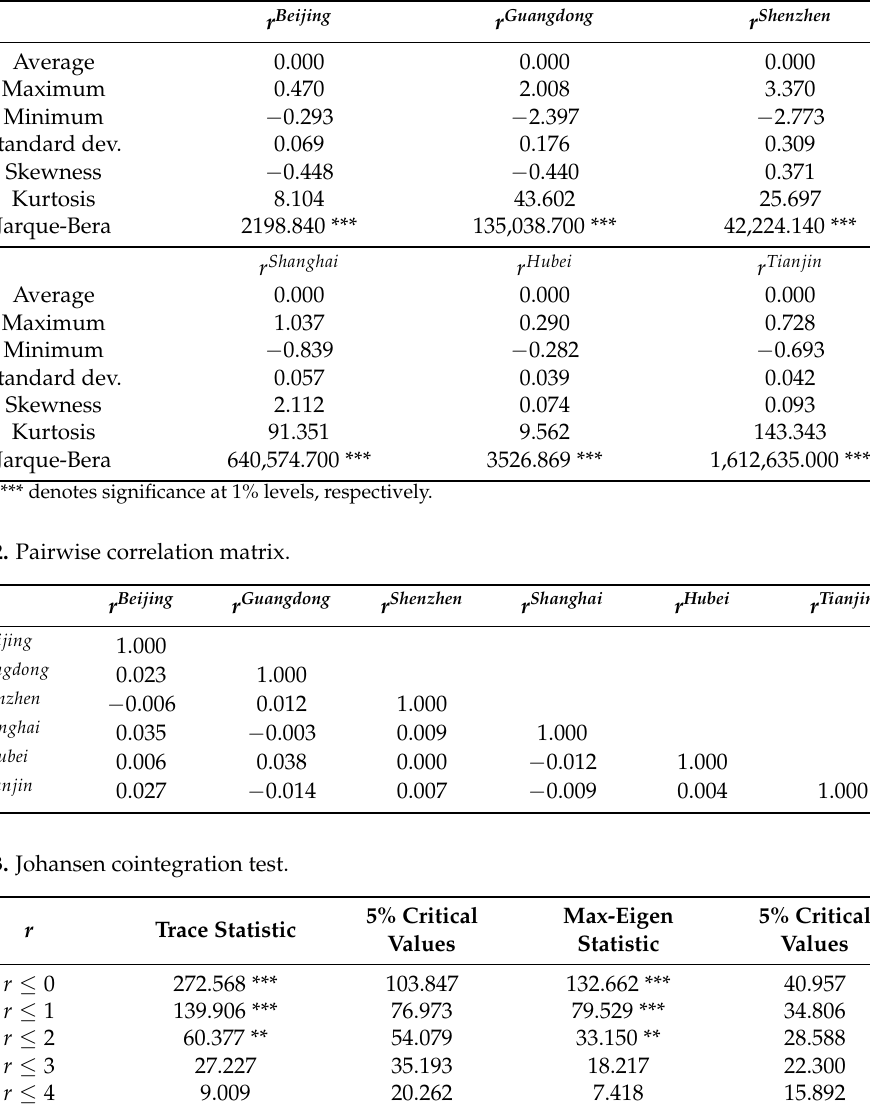
Table 1. Summary statistics.